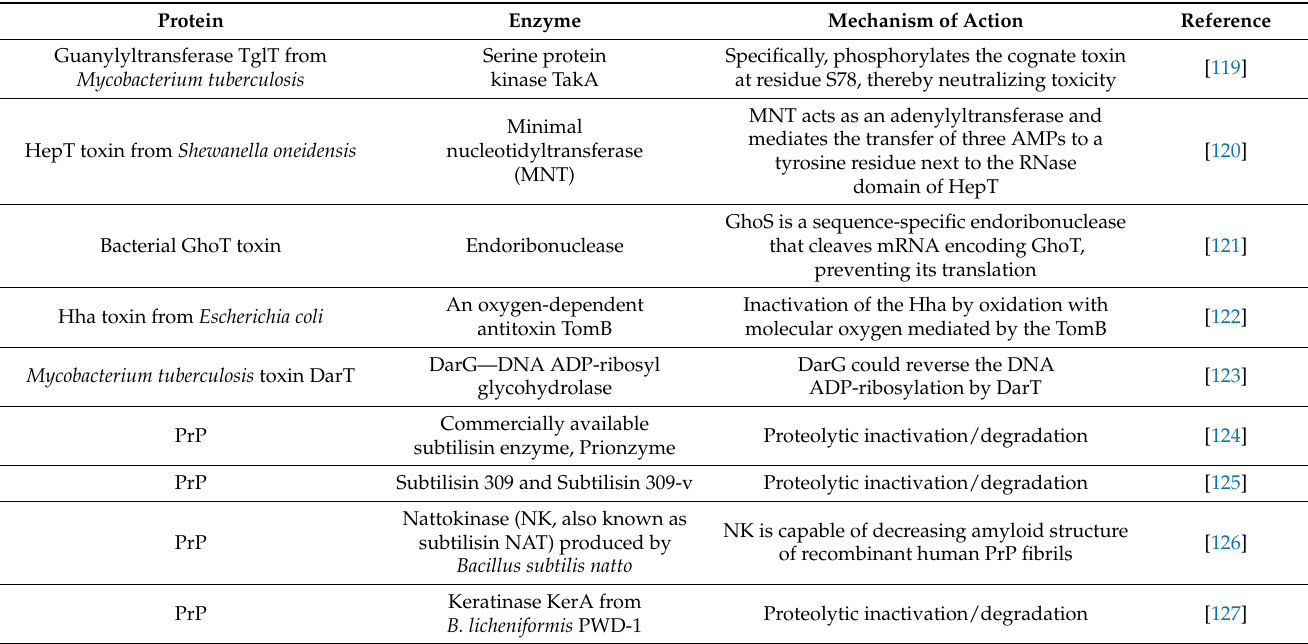
Table 3. Enzymes as antidotes for toxic and prion